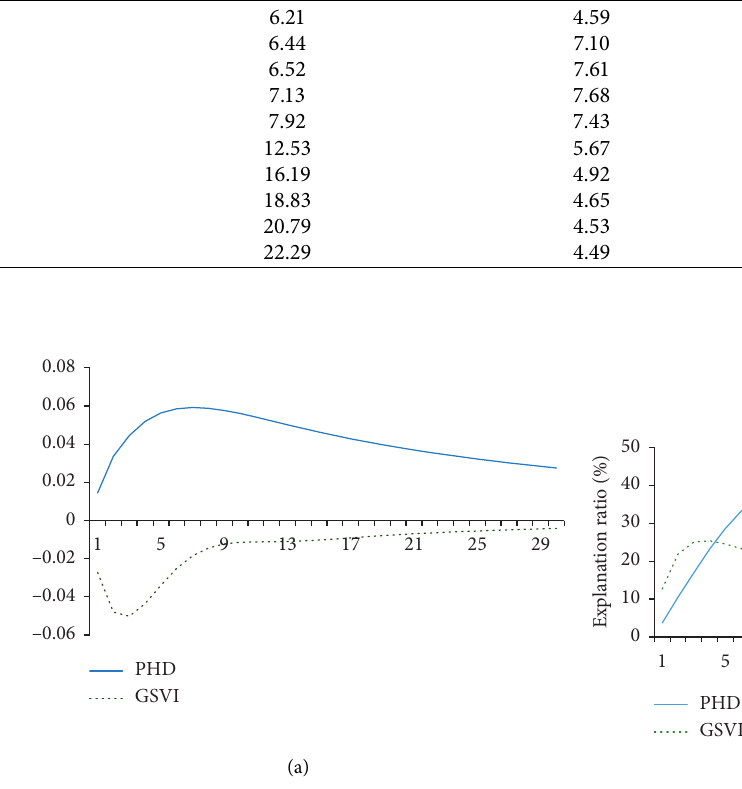
Figure 7: Comparison of the impact of PHD and GSVI on oil prices based on IMF and VD. (a) The response of oil prices based on IMF. (b) Comparison of explanation ratio based on VD.